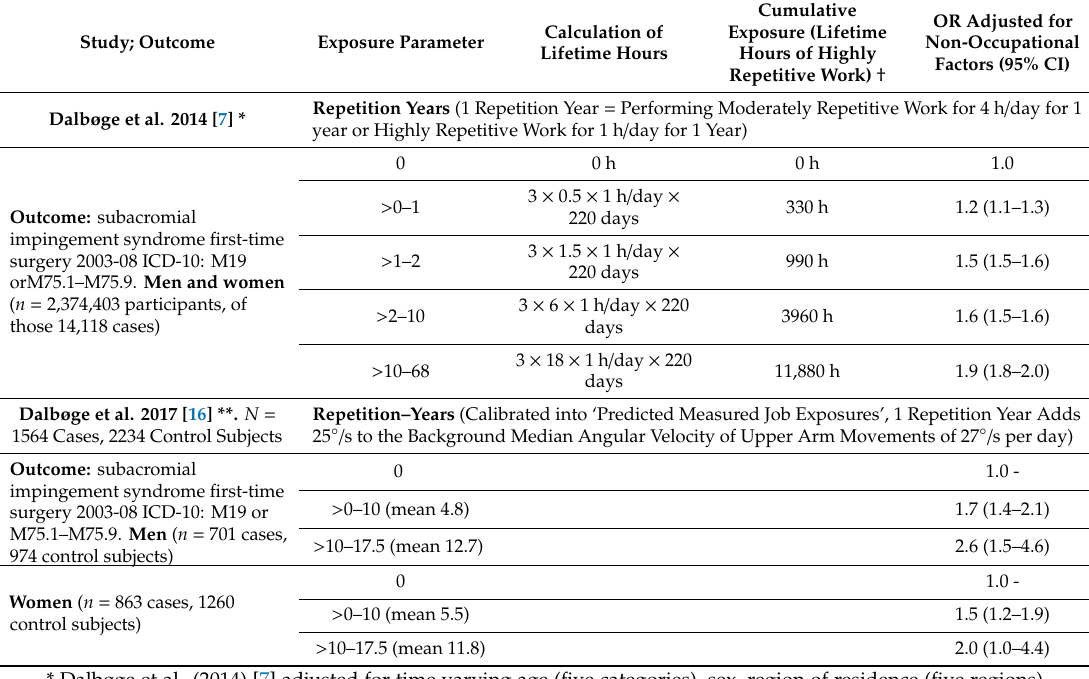
Cumulative OR Adjusted for Calculation of Exposure (Lifetime Non-Occupational Lifetime Hours Hours of Highly Factors (95% CI) Repetitive Work) †